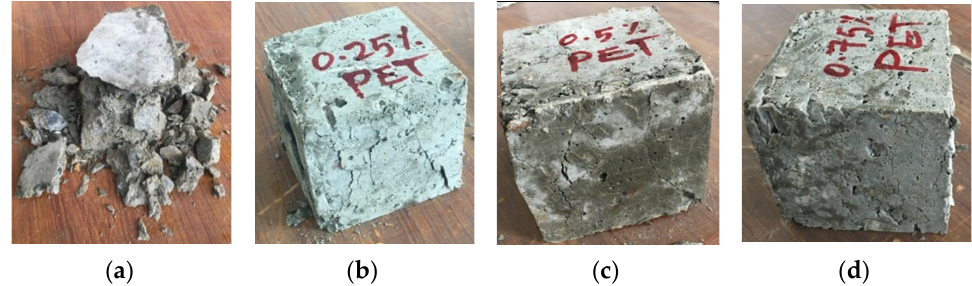
Figure 20. Cracking mechanisms after the compression test. ( a ) Reference, ( b ) 0.25%, ( c ) 0.50%, and ( d ) 0.75% .